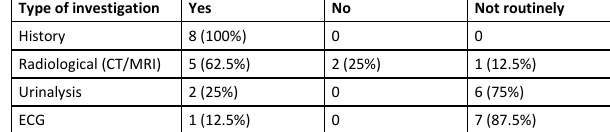
Table 4: Number (%) of major Swiss tertiary referral centres ordering various investiga- tions. 12 Type of investigation Not routinely